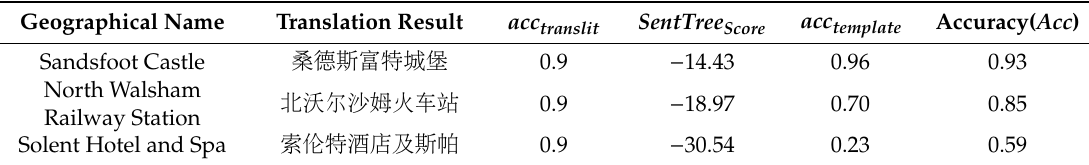
Table 6. Evaluation parameters of translation results